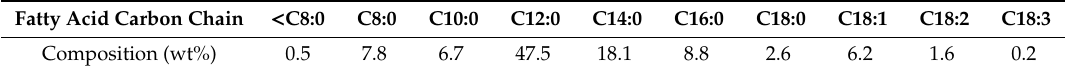
Table 2. Fatty acid profile of coconut oil. Reprint with permission, 2020, Elsevier [26]. Fatty Acid Carbon